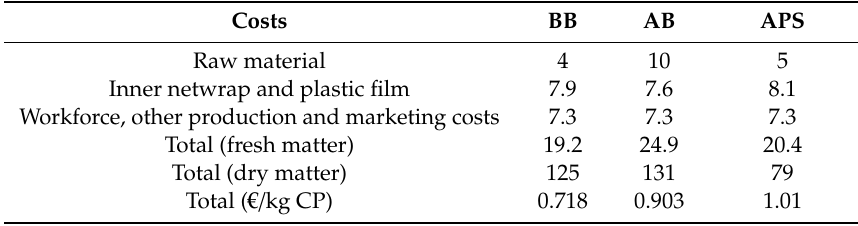
Table 3. Approximate manufacturing costs ( € / t) of broccoli by-product (BB), artichoke by-product (AB) and artichoke plant stubble (APS) silages in 300 kg round bale silos on commercial